Question: Summarize what this figure shows in one sentence.
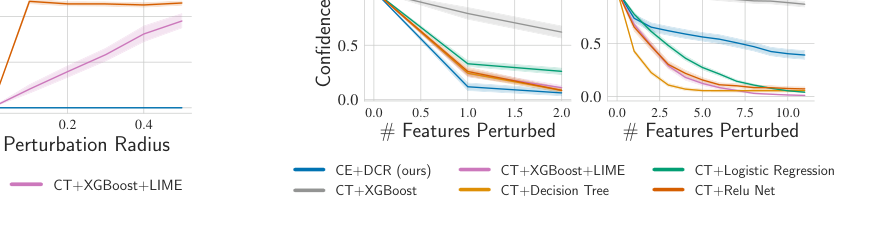
Answer: Model conﬁdence as a function of the number of per- turbed features on counterfactual examples. The lower, the better. Similarly to interpretable methods, DCR prediction conﬁdence quickly drops after inverting the truth degree of a small set of relevant concepts, facilitating the discovery of counterfactual ex- amples.